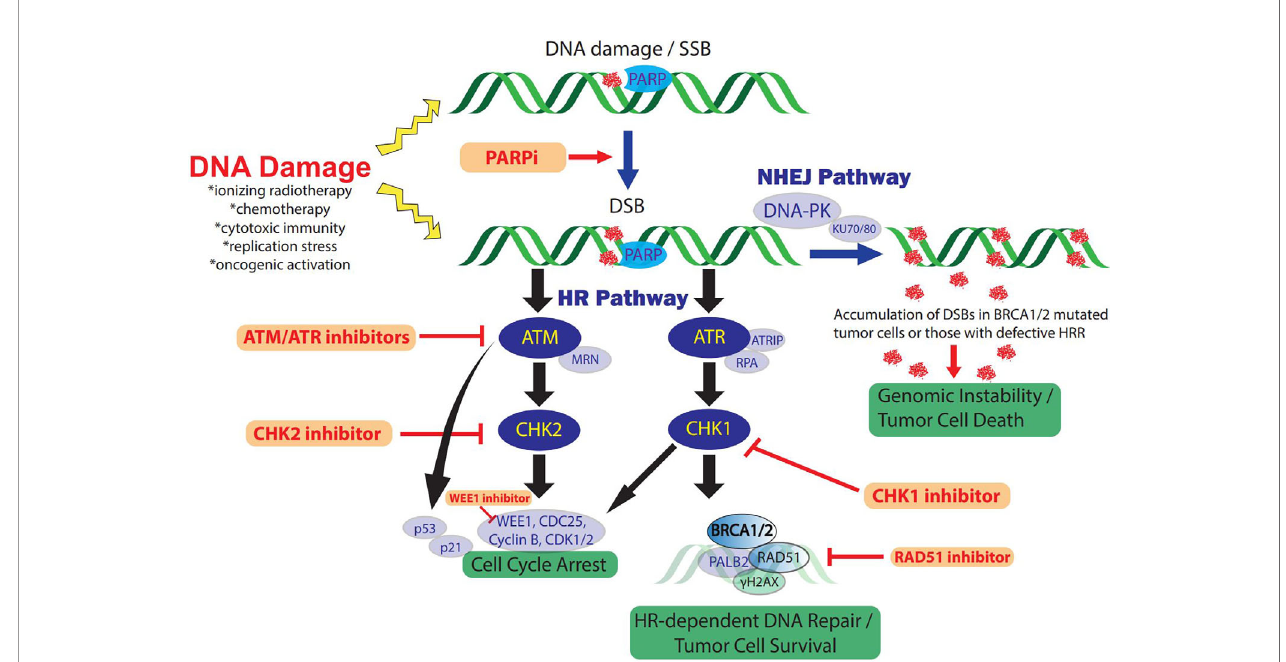
FIGURE 1 | The DDR and therapeutic strategies in TNBC . DNA-damaging therapies or endogenous replication dysfunction result in SSBs and DSBs which activate the DDR and repair signaling pathways. Distinct DSB DDR signaling pathway initiation depends on the type of DNA damage and is mediated by three central DDR kinases: DNA-PK, ATM, and ATR. In addition, PARP enzymes play a key role in DDR and facilitate SSB repair ef fi ciency and functions in DSB repair via HRR and NHEJ pathways. The ATM and ATR pathways cross-talk extensively and only key intersections are highlighted here for pragmatic purposes. ATM/CHK2 signaling induces cell cycle arrest, preventing cell cycle progression in tumor cells with DNA damage. In addition, ATR/CHK1/WEE1 signaling initiates DNA DSB repair by inducing checkpoints and activating key components of HRR, including BRCA1/2 activity. Alternatively, DSB repair occurs through NHEJ via DNA-PKcs recruitment. Inhibition of PARP to treat TNBC with defects in HRR such as BRCA1/2 mutations, induces DSBs from unrepaired SSBs via PARP trapping and collapsed replication forks. Accumulated PARPi-induced DNA damage cannot be effectively repaired due to the HRR de fi ciency, resulting in genomic instability and cell cycle arrest. In addition, loss of function or inhibitors (red) against other key mediators of HRR also constrain NHEJ dependence which can be overwhelmed in the setting of concomitant PARPi via accumulation of DSB and genomic instability. RAD51 inhibition also suppresses HRR and sensitizes TNBC to PARPi. ATM/ ATR/CHK1/WEE1 inhibition increases DSBs and impairs cell cycle arrest checkpoints and DNA damage repair, ultimately resulting in tumor cell death. DDR, DNA damage response; SSB, single-strand breaks; DSB, double-stranded breaks; DNA-PK, DNA-dependent protein kinase; ATM, ataxia telangiectasia-mutated; ATR, ataxia telangiectasia and Rad3-related protein; NHEJ, non-homologous end-joining; HR(R), homologous recombination repair; PARP, poly (ADP-ribose) polymerase; PARPi, PARP inhibitor/inhibition; MRN complex, Mre11, Rad50, Nbs1; ATRIP, ATR-interacting protein; RPA, replication protein